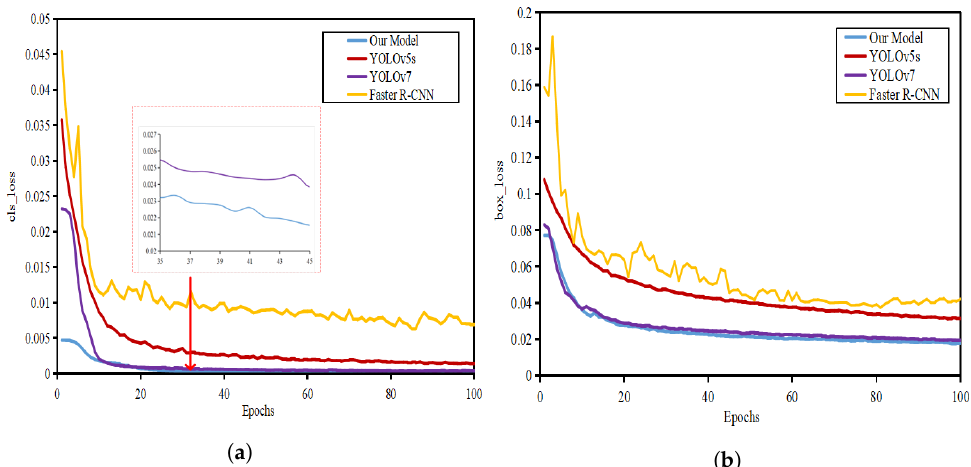
Figure 14. Comparison of training loss curves of different models: ( a ) cls-loss curve; ( b ) box- loss curve.